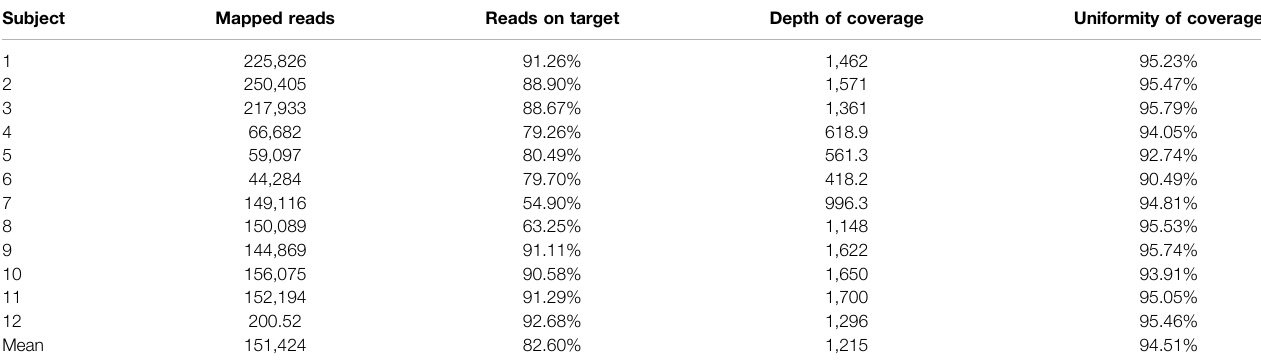
TABLE 1 | Coverage metrics of the customized gene panel, that includes the IDS